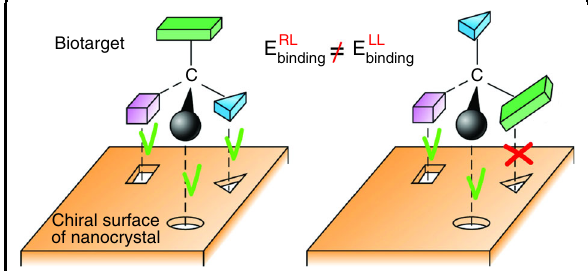
Fig. 1 A cartoon showing the process of enantioselective recognition of a chiral biotarget on the chirally distorted surface of a nanocrystal. The process is driven by the difference in the formation energies of the complex with heterogeneous (e.g., right- left) and homogeneous (e.g., left-left)